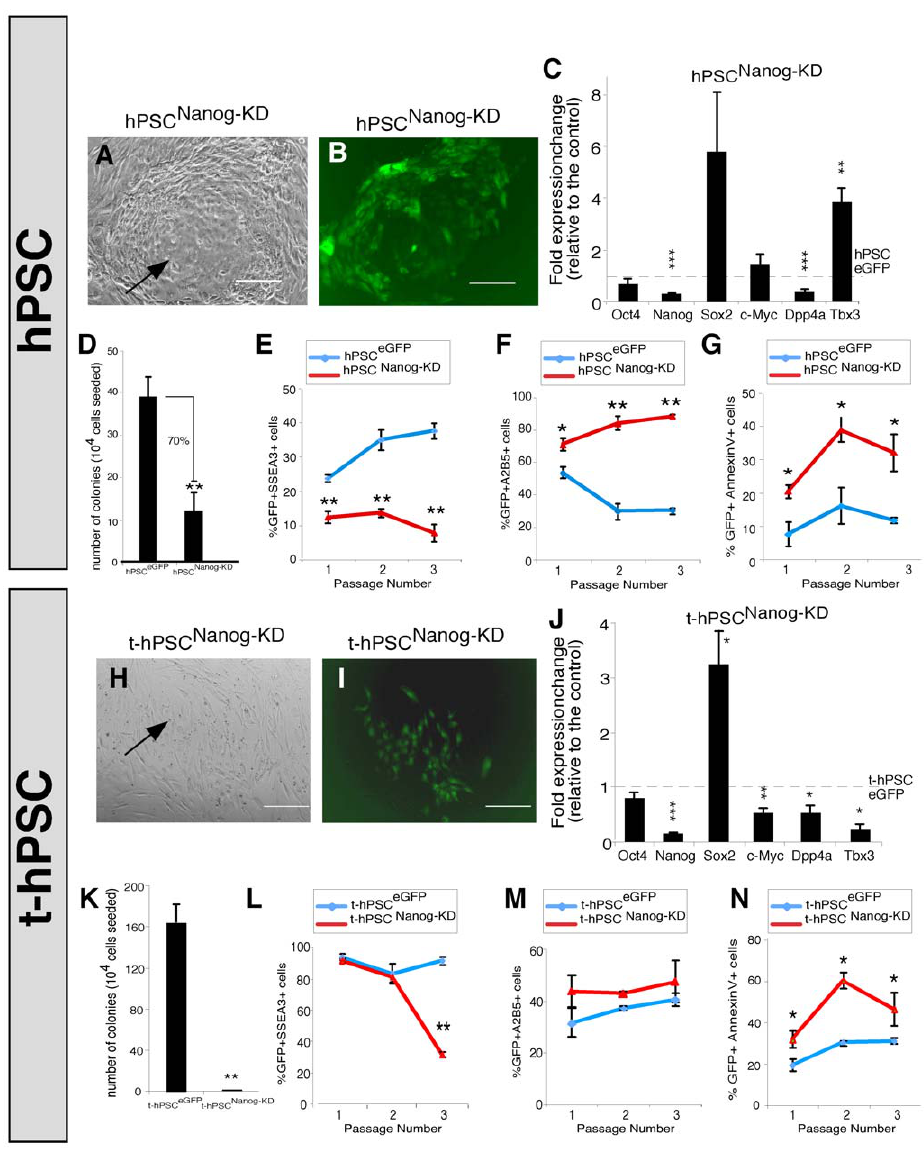
Figure 3. t-hPSCs exhibit a heightened self-renewal and survival response following Nanog dysregulation. (A–B) Representative images of normal hPSC bulk culture one week after transduction with a lentivector carrying an shRNA sequence targeting Nanog. Scale bar=100 m m, n=5. A: Phase contrast. B: GFP. Note the less compact colony morphology and the differentiated interior. Arrow denotes differentiated cells in the hPSC colony centre following Nanog knockdown. (C) qPCR demonstrating fold changes in Oct4, Nanog, Sox2, c-Myc, Dpp4a, and Tbx3 transcripts in GFP + SSEA3 + cells isolated from Nanog knockdown hPSCs relative to the control, respectively. Bar graphs represent mean values 6 SEM, n=3. **, p , 0.01, ***, p , 0.001. (D) Clonogenic self-renewal of SSEA3 + cells isolated from control and Nanog knockdown hPSCs. 1 6 10 4 GFP + SSEA3 + cells were isolated from hPSCs 2 days after transduction with eGFP control and Nanog knockdown lentiviral vectors and seeded on ihdFs. GFP + colonies were scored 9 days after seeding. Bar graphs represent mean values 6 SEM, n=3. **, p , 0.01. (E–G) Frequency of GFP + SSEA3 + (E) GFP + A2B5 + (F) and GFP + AnnexinV + (G) cells for three passages of culture derived from sorted GFP + SSEA3 + fractions of control and Nanog knockdown hPSCs. Lines represent mean values 6 SEM, n=3. * p , 0.05, ** p , 0.01. (H–I) Representative images of t-hPSC bulk culture one week after transduction with a lentivector carrying an shRNA sequence targeting Nanog. Scale bar=100 m m, n=5. H: Phase contrast. I: GFP. Arrow denotes t-hPSCs undergoing apoptosis following Nanog downregulation. (J) qPCR demonstrating fold changes in Oct4, Nanog, Sox2, c-Myc, Dpp4a, and Tbx3 transcript in GFP + cells isolated from Nanog knockdown t-hPSCs. Bar graphs represent mean values 6 SEM, n=3, *, p , 0.05, **, p , 0.01, ***, p , 0.001. (K) Clonogenic self-renewal of GFP + cells isolated from control and Nanog knockdown t-hPSCs. 1 6 10 4 were sorted from t-hPSCs 4 days after transduction with eGFP control and Nanog knockdown lentiviral vectors and seeded on ihdFs. GFP + colonies were scored 6 days after seeding. Bar graphs represent mean values 6 SEM, n=3. **, p , 0.01. (L–N) Frequency of GFP + SSEA3 + (L) GFP + A2B5 + (M) and GFP + AnnexinV + (N) cells for three passages of control and Nanog knockdown t-hPSCs. Lines represent mean values 6 SEM, n=3. * p , 0.05.** p , 0.01. doi:10.1371/journal.pone.0008065.g003 (Figure 3L–M). This demonstrated that unlike normal hPSCs, increased frequency of Annexin V + cells (Figure 3N). Together, Nanog does not regulate t-hPSC neural differentiation. t-hPSCs these results demonstrate a potent and distinct hypersensitivity of t- also underwent a significant apoptotic induction shown by an hPSCs to Nanog.